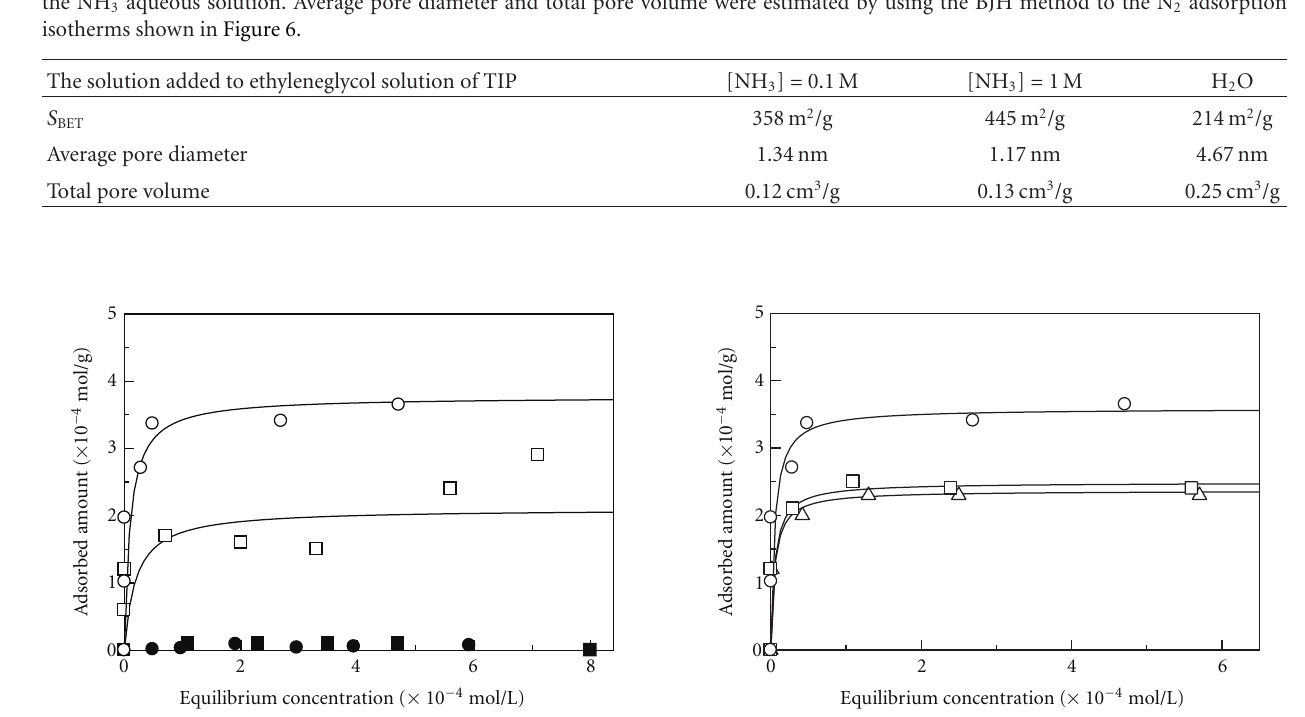
Figure 8: Adsorption isotherms of methylene blue on the titanium oxide nanoparticles in aqueous solution of dye. The NH 3 aqueous solutions concentrations used to prepare the titanium oxide nanoparticles were the following: (cid:3) , 1 mol/L; (cid:2) , 0.2 mol/L; (cid:4) ,